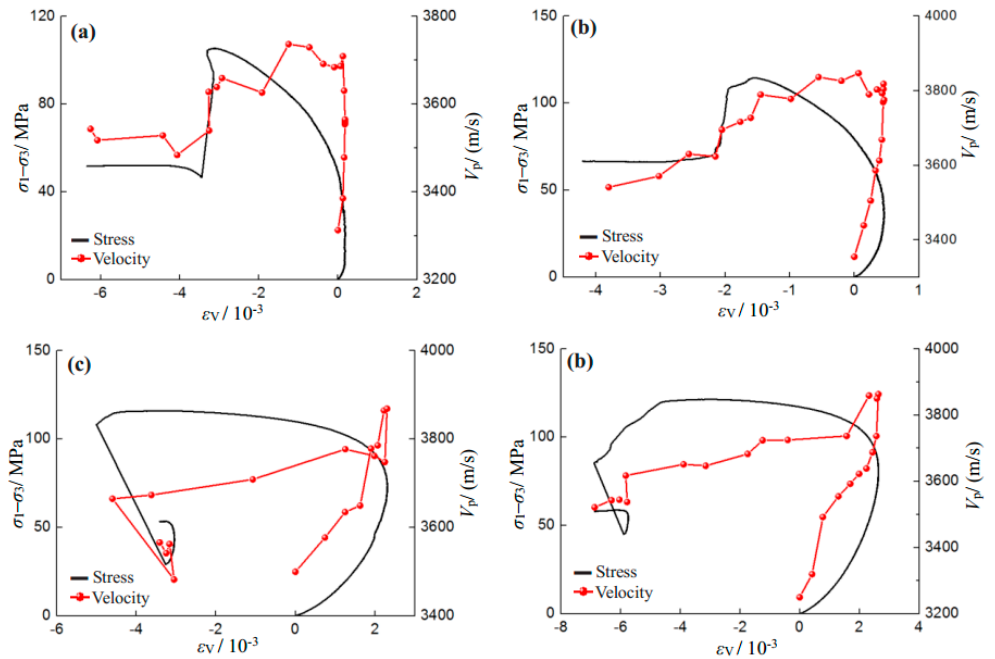
Figure 11. P-wave velocity against volumetric strain during complete failure process with respect to various salinity levels. ( a ) Water, σ 3 = 10 MPa; ( b ) 10% NaCl, σ 3 = 10 MPa; ( c ) 20% NaCl, σ 3 = 10 MPa; and ( d ) 30% NaCl, σ 3 = 10 MPa.